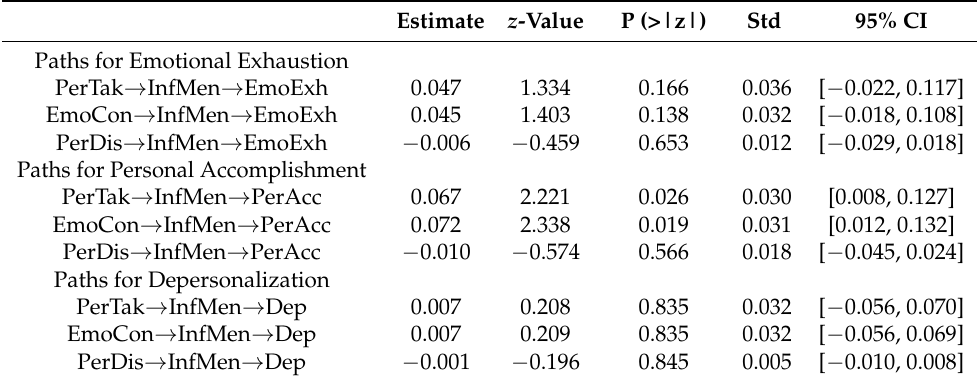
Table 3. Indirect paths from dimensions of empathy to burnout dimensions through the inference of mental states for the models of multiple mediation analyses.